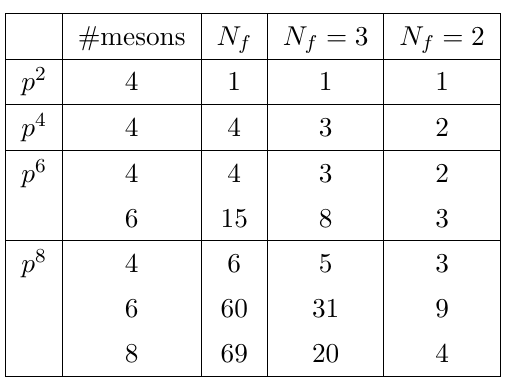
Table 6 . Number of monomials in the minimal basis for the case with no external (cid:12)elds included. There are no contact terms in this case.